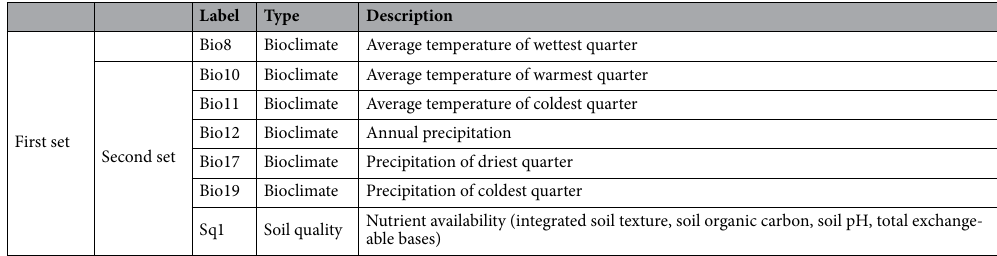
Table 1. Two sets of environmental variables for model